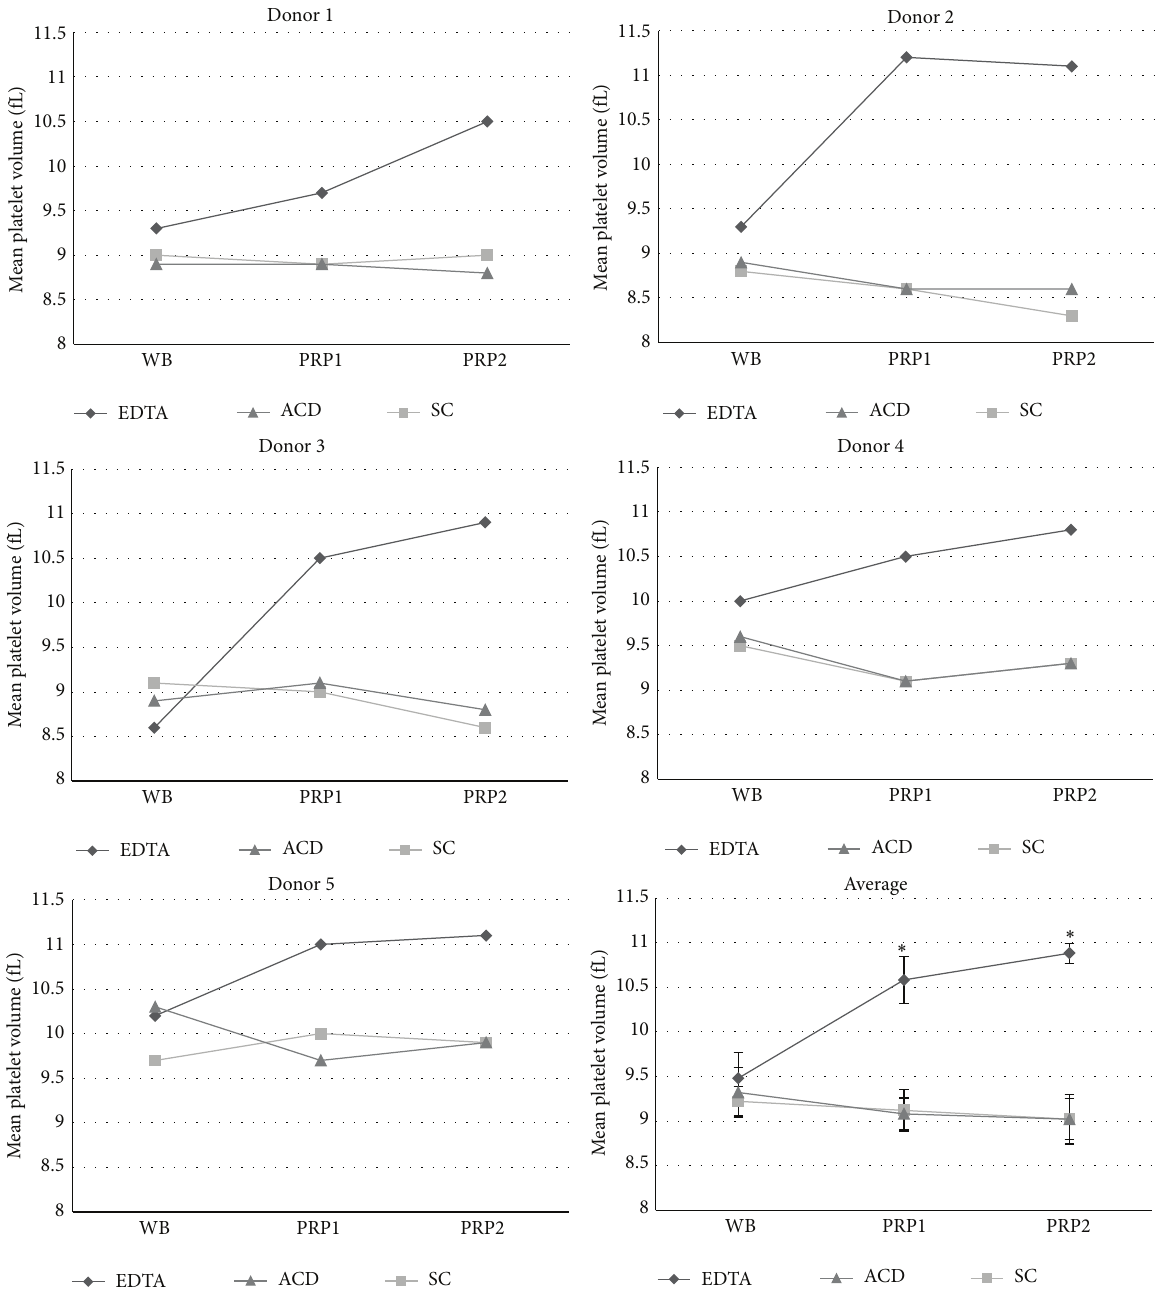
Figure2:Meanplateletvaluequantificationofsamplescontainingdifferentanticoagulants.Meanplateletvaluewasquantifiedinfivedifferent donors in whole blood (WB), PRP1, and PRP2, in tubes containing EDTA, SC, or ACD solution. The average values of the five different donors are also represented in the figure. “ ∗ ” corresponds to statistical difference between EDTA and SC groups as well as EDTA and ACD groups ( 𝑝 < 0.05